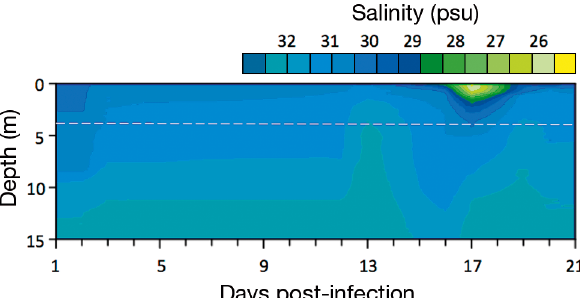
Fig. 2. The daily environmental salinity profile over the experimental period, taken at a reference point outside of the experimental cage. The dotted white line indicates the depth above which infection pressure was known to be